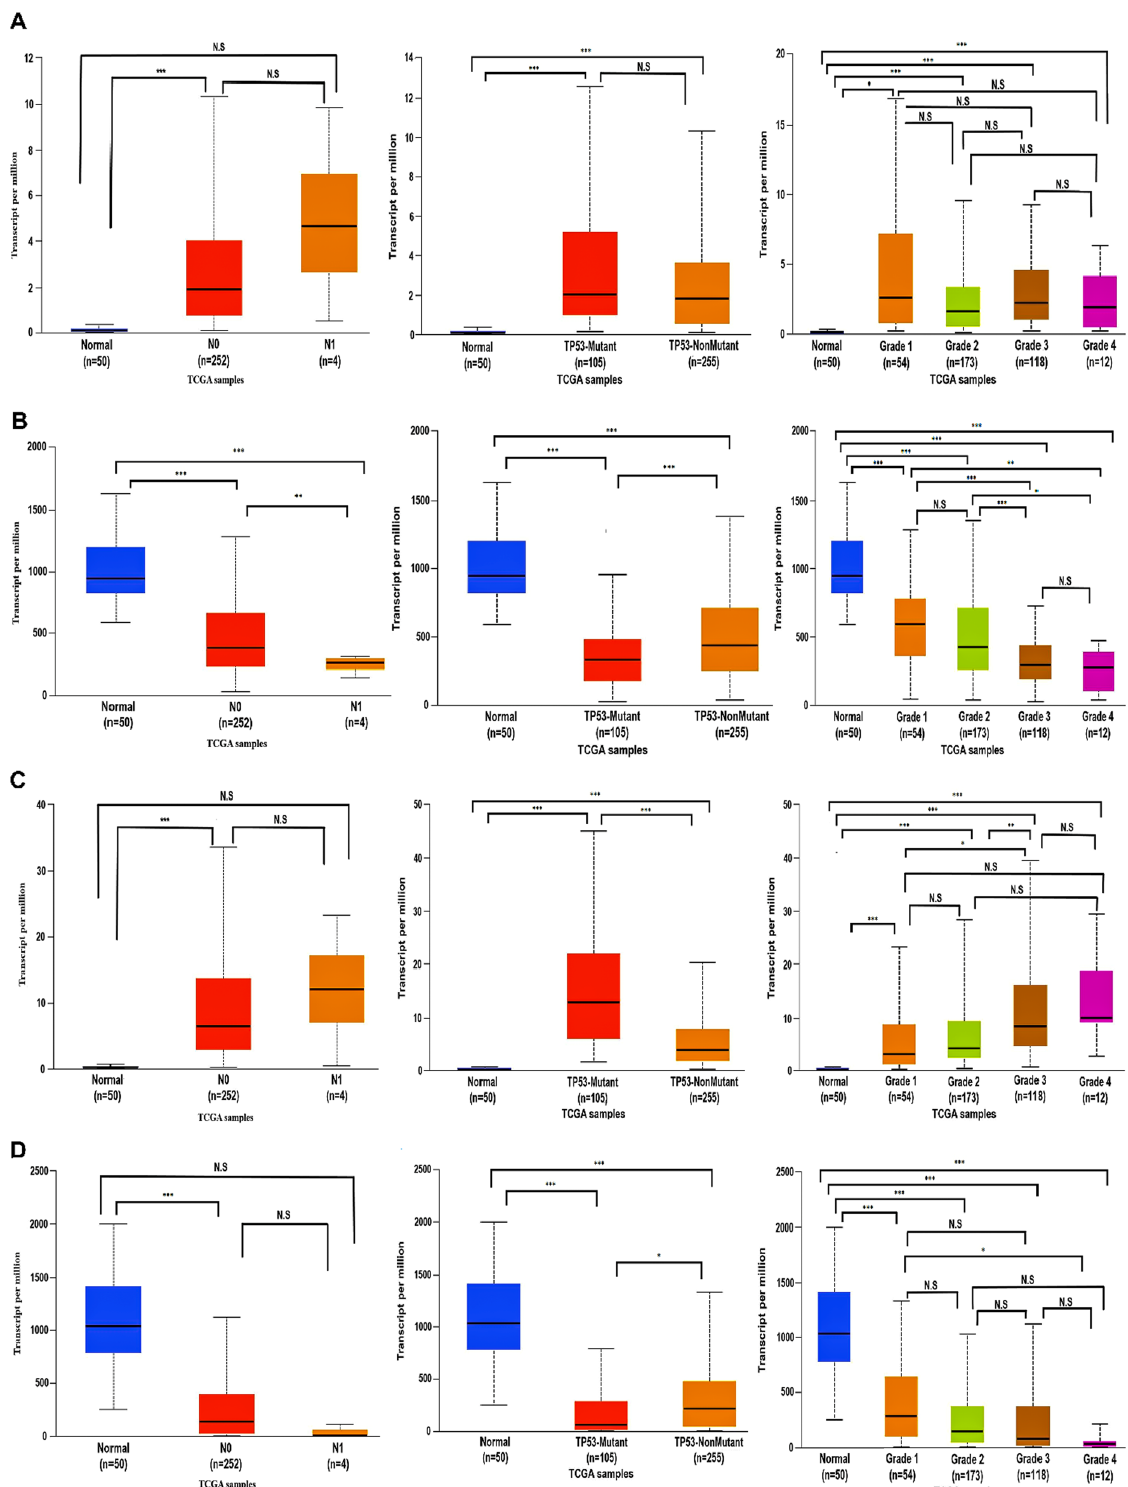
Fig. 5 Box-and-whisker plots displaying expression distribution of A APLN, B ALDH2, C E2F1, and D PCK1 based on nodal metastasis status (N0 means no regional lymph node metastasis; N1 means metastases in 1 to 3 axillary lymph nodes), TP53 mutation status, and tumor grade across TCGA-HCC cohort. * P value < 0.05 , ** P value < 0.01 , *** P value <